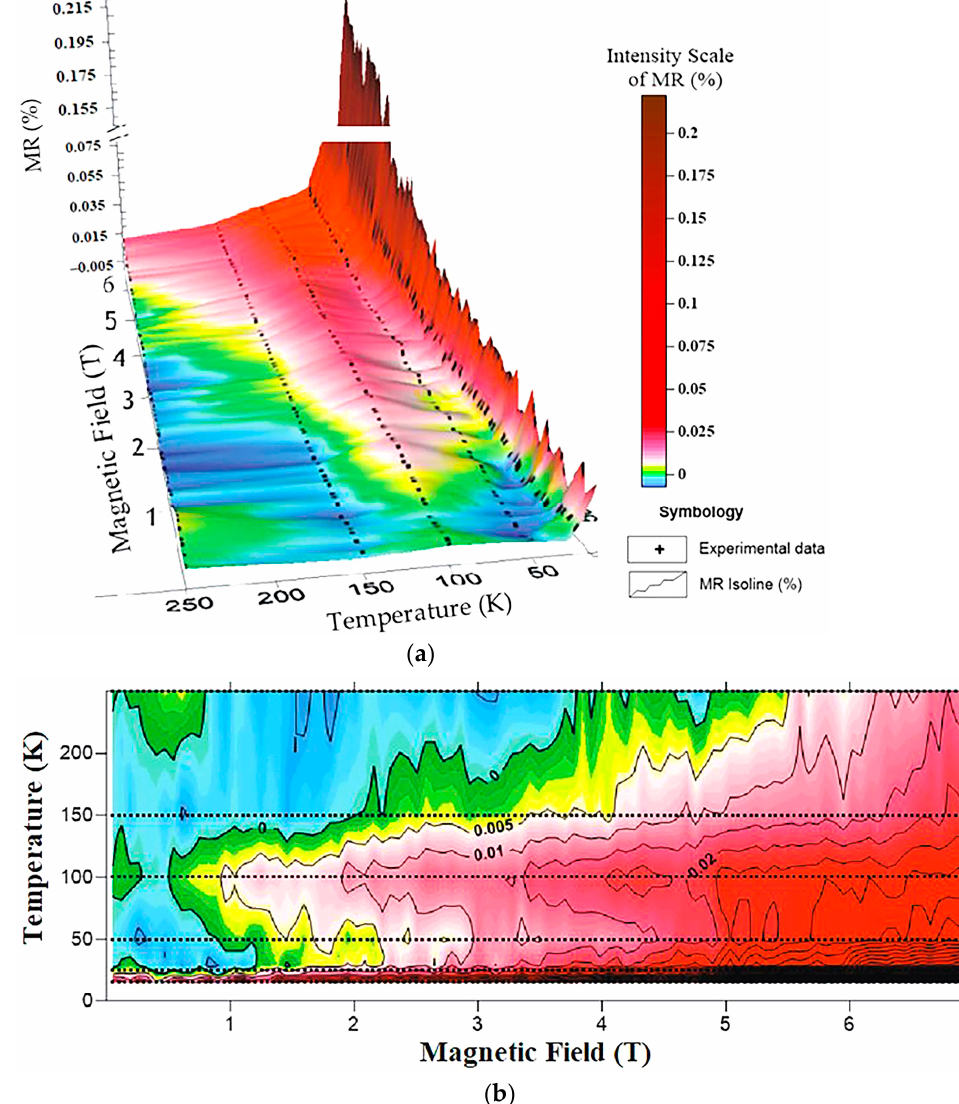
Figure 7. ( a ) Three-dimensional image of the MR in function of the temperature and the magnetic field of Sample I. ( b ) Isoline map of the MR.